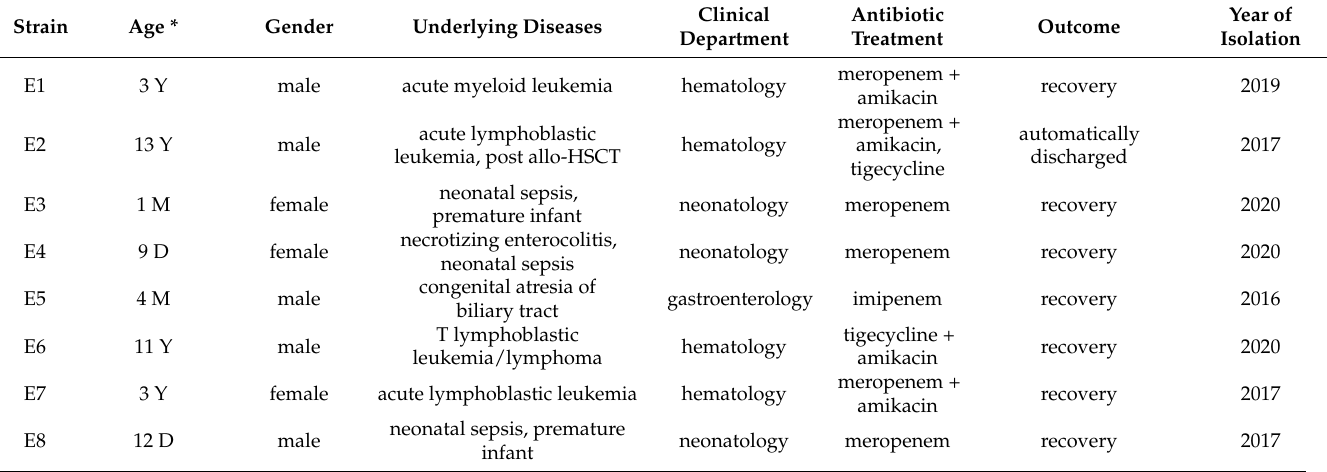
Table 1. Clinical information of the